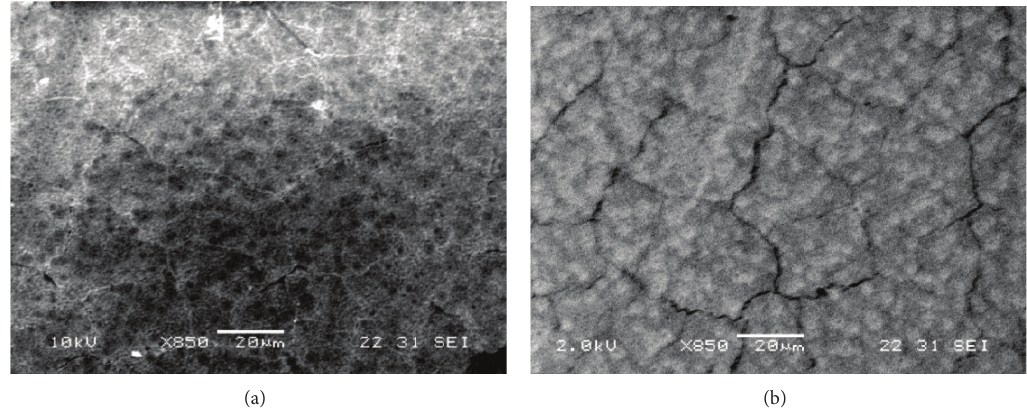
Figure 5: SEM images of a 125nm thick BiFeO 3 film prepared at a source-to-substrate distance of 2 󸀠󸀠 . (a) was obtained with accelerating voltage of 10kV. (b) was obtained with 2.5kV. Large ( ∼ 50 𝜇 m) grains are observed along with smaller features related to the ferroelectric domain structure.